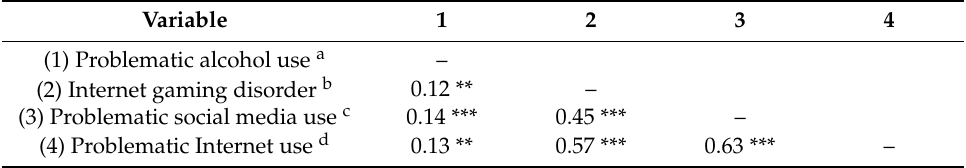
Table 2. Bivariate correlation analyses regarding the relationships of problematic alcohol use, problematic gaming behavior, problematic social media use and problematic Internet use in